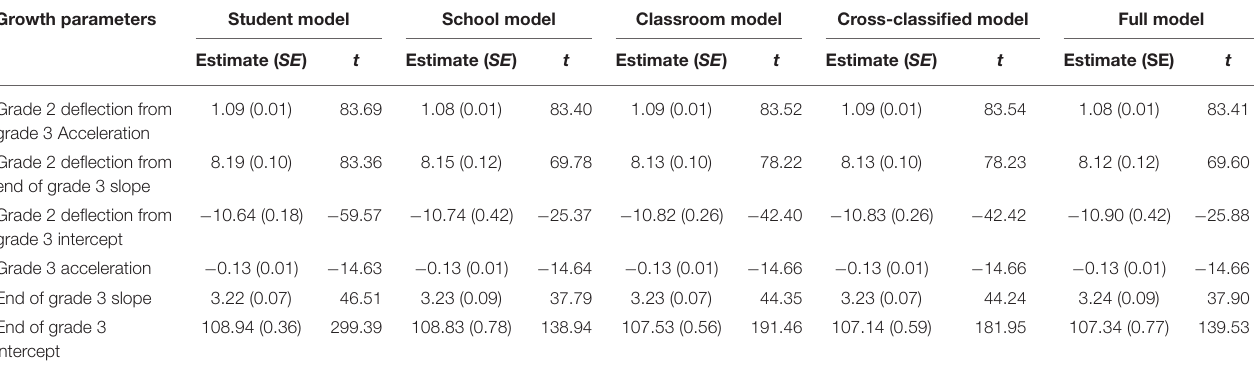
TABLE 4 | Estimates of fixed parameters for growth models ( N =